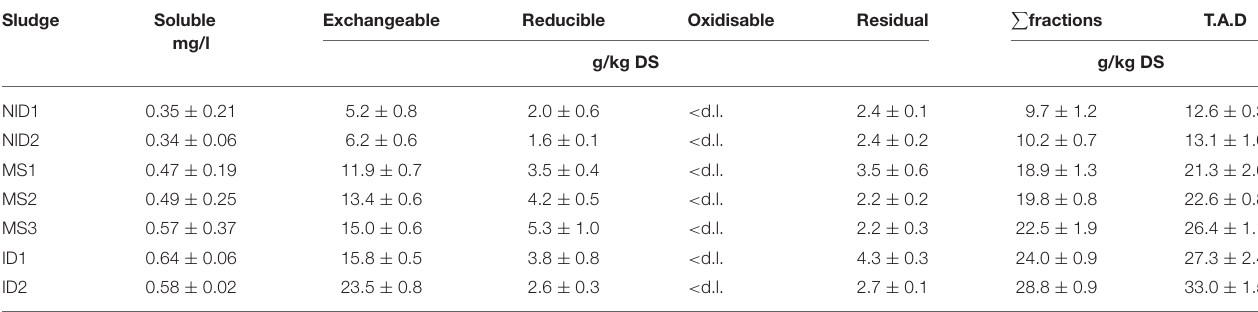
TABLE 2 | Concentrations of iron in each BCR sequential extraction fraction and total acid digestion (T.A.D.) for the 7 anaerobically digested sludge. Sludge